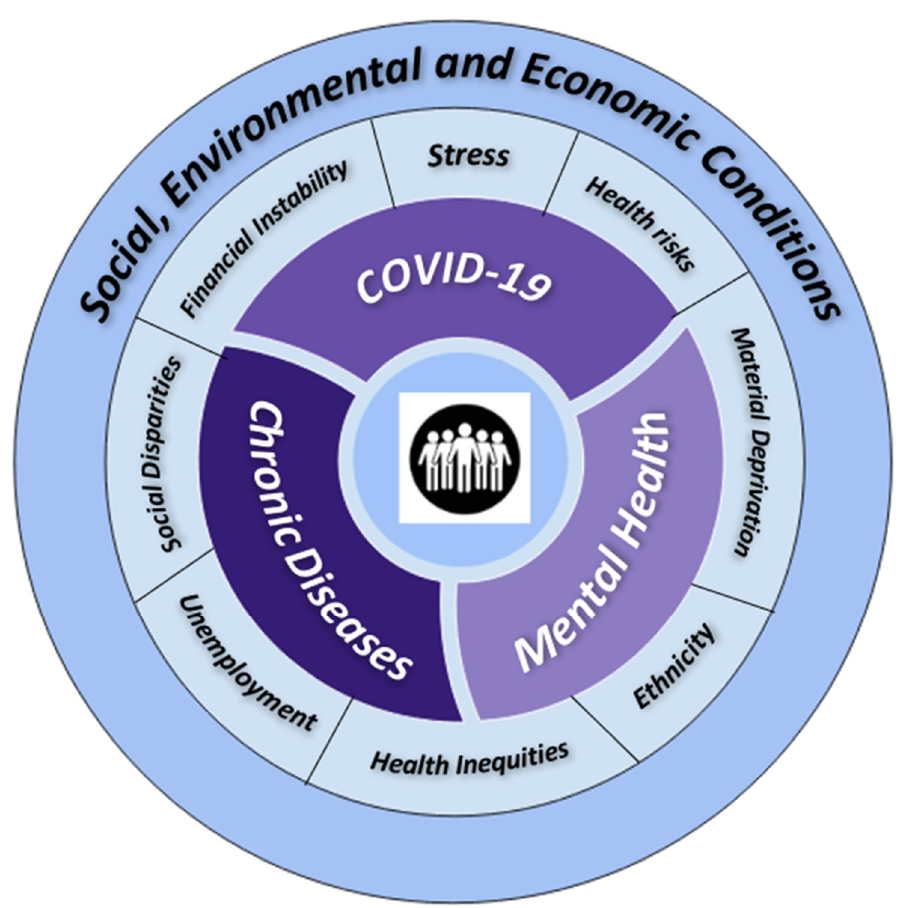
Figure 1. Conceptual framework for COVID-19, Mental Health, and Chronic diseases Syndemic.